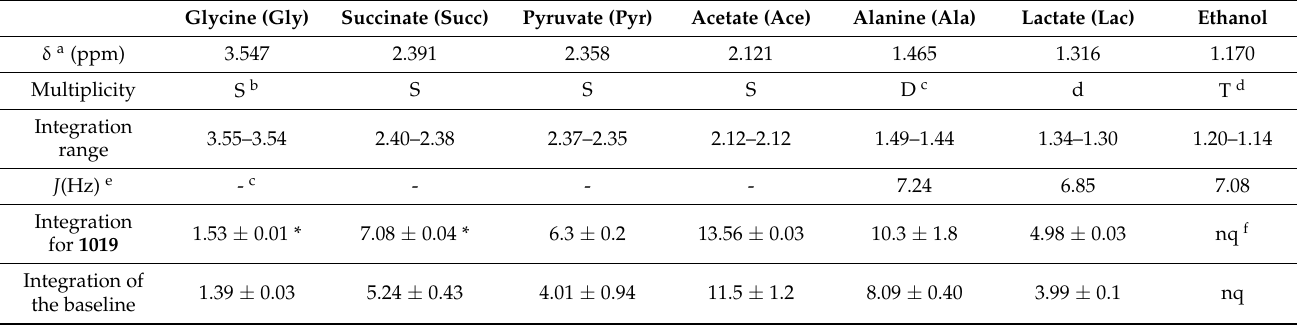
Table 2. Signals used in 1 H-NMR experiments to identify the metabolites excreted in the culture medium by epimastigotes of T. cruzi , strain Y, and results for compound 1019